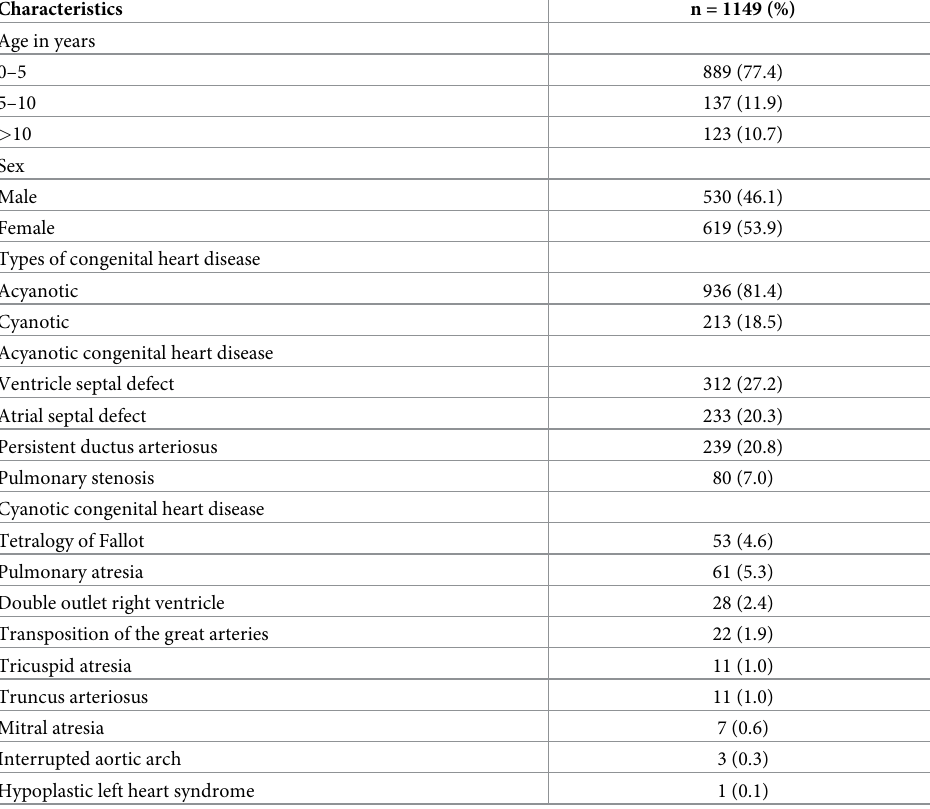
Table 1. Baseline characteristics among children with congenital heart